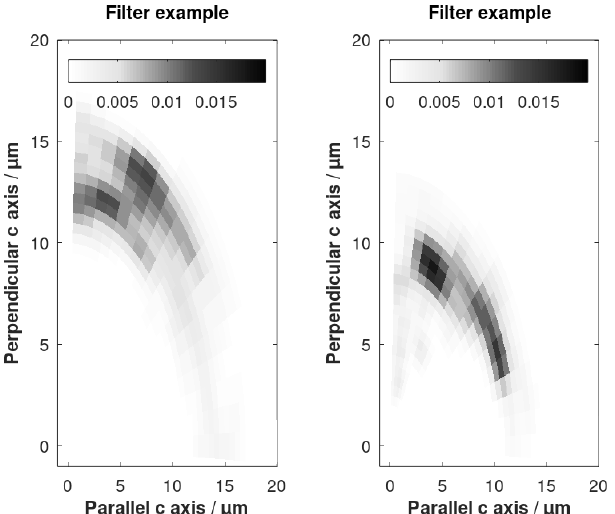
Figure E4. The combined 3D histogram considered as synthetic data (Fig. E1) and the forward-simulated approximation using the posterior model in Eq. (24). The greyscale range denotes the num- ber of